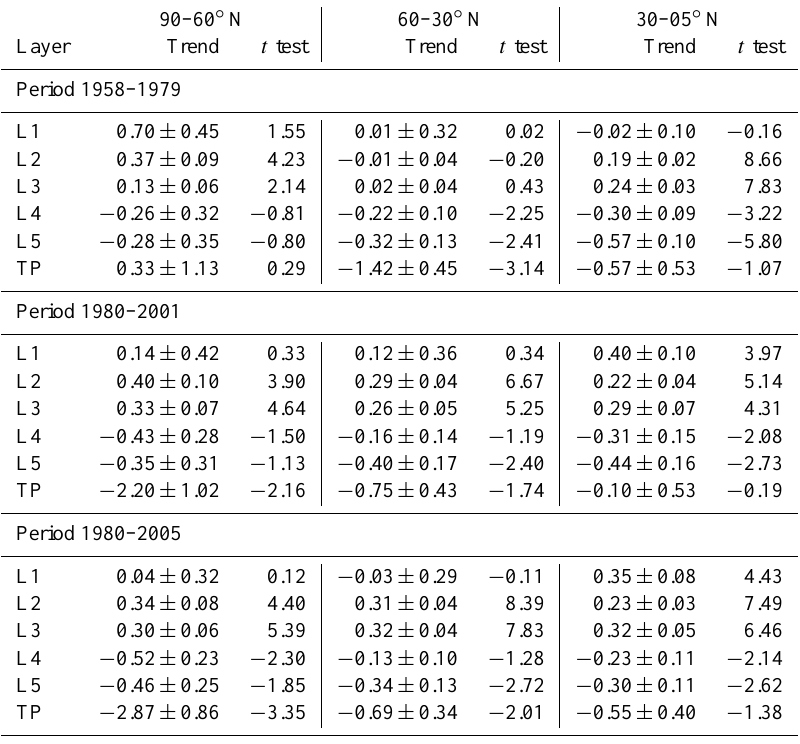
Table 2. Trend calculations in Northern Hemisphere summer (JJA) based on the monthly normalized time series of the layer mean temper- ature ( ◦ Cdecade − 1 ) and tropopause pressure (TP; hPadecade − 1 ) calculated from the WACCM model and filtered from natural variations at the latitudinal belts: (a) 5–30 ◦ N, (b) 30–60 ◦ N and (c) 60–90 ◦ N. The layers are as follows: L1: 1000–925hPa, L2: 925–500hPa,